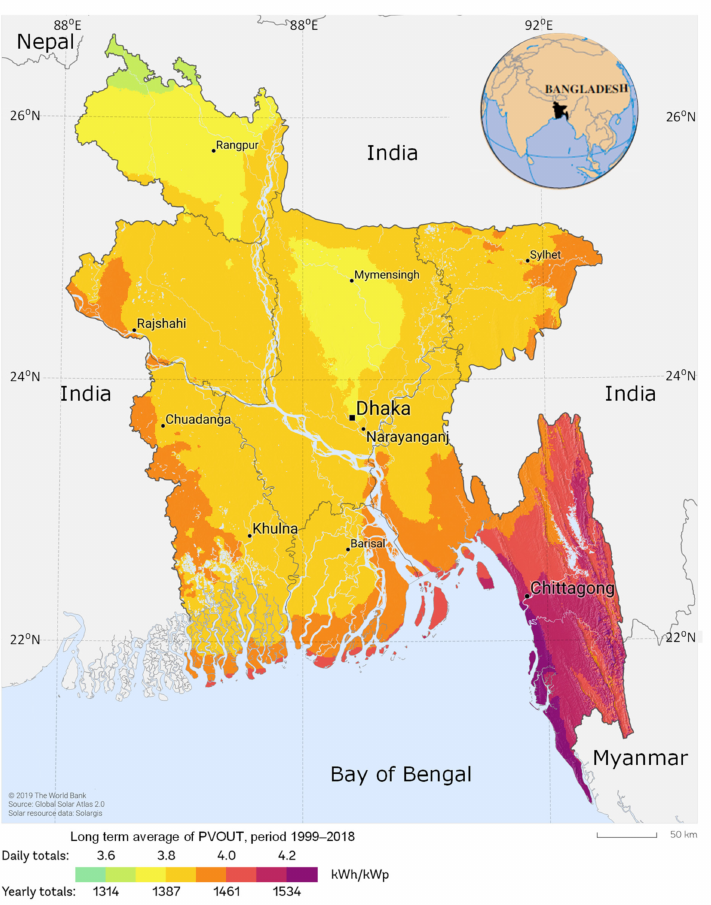
Figure 5. Geographical location and the photovoltaic power potential map of Bangladesh [53].